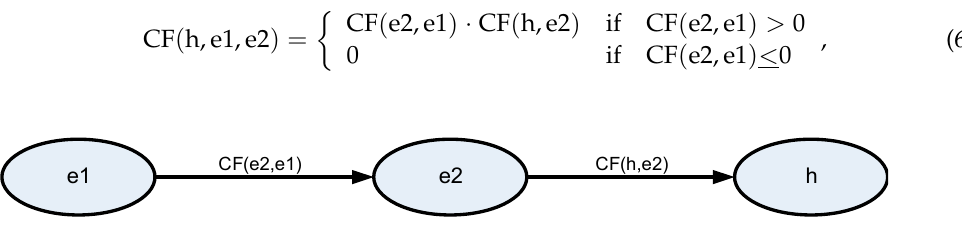
Figure 3. Serial transitions between two observations and a hypothesis. Both connections, parallel and series, can be reduced to one connection, as shown in Figure 4. This property enables the simplification of calculations in the model proposed in the next chapter.